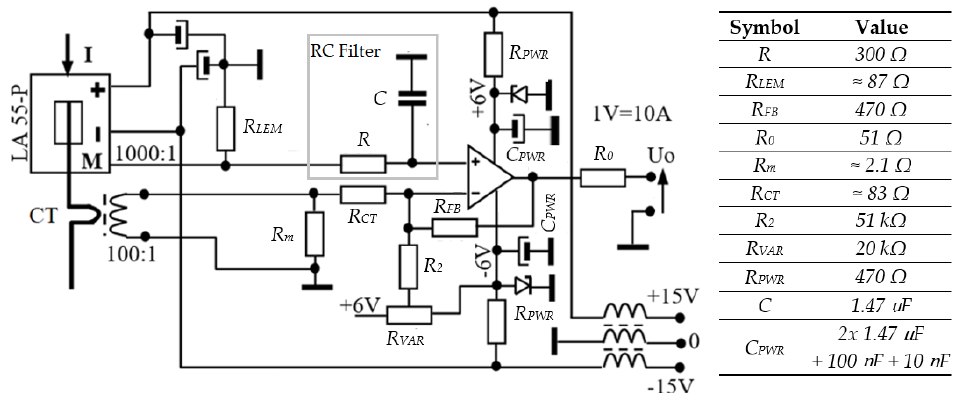
Figure 2. Schematic (simplified) of the proposed sensor with the LA 55-P sensor and current transformer with the ADS8000TRDZ operational amplifier.